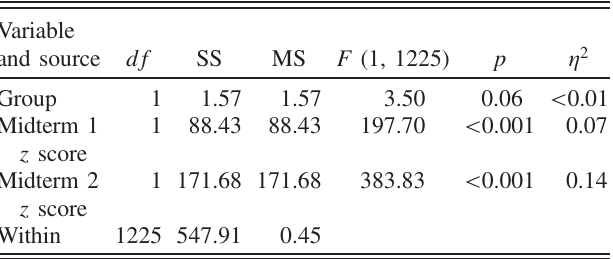
TABLE II. One-way ANCOVA for the effects of semester and student ability (proficiency) on midterm exam 3 scores. Note that type III sum of squares and mean squares, and semipartial eta square are